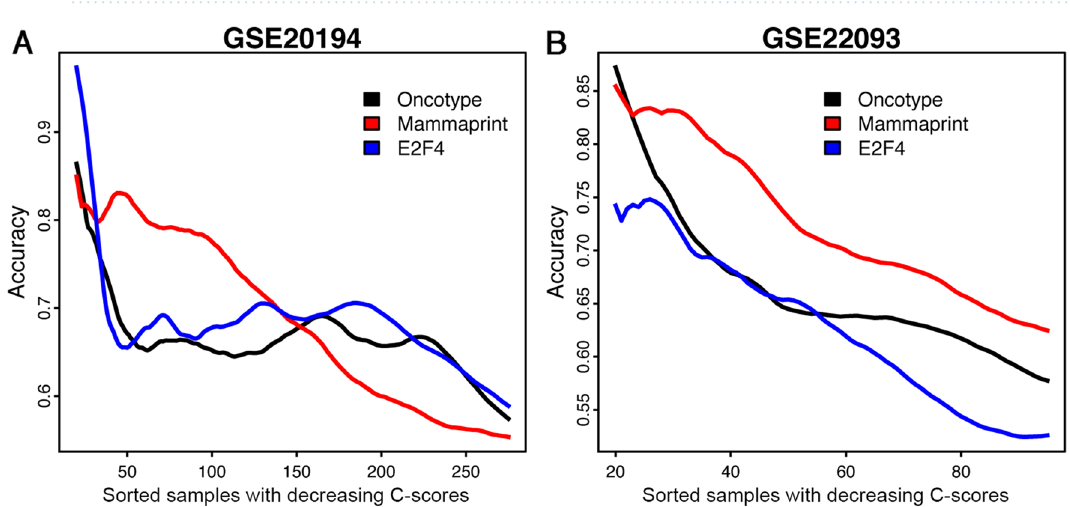
Figure 3. Applying MammaPrint and an E2F4 signature to predict patient response to neoadjuvant chemotherapy in breast cancer. ( A ) The prediction accuracy of the CPM models is based on the Oncotype DX, the MammaPrint, and the E2F4 scores, respectively, and ( B ) the prediction accuracy of the corresponding PPMs. AUC scores were estimated based on tenfold cross-validation using the Hatzis discovery data. ( C ) Application of the CPM/PPMs trained from the discovery data to patients in the validation cohort, and ( D ) vice versa. Patients are sorted in the decreasing order of their confidence scores from the PPM, and the average prediction accuracy of the CPM in the top N patients was calculated from N = 1 to all patients. The curve was smoothed by averaging values within a sliding window of size 20.